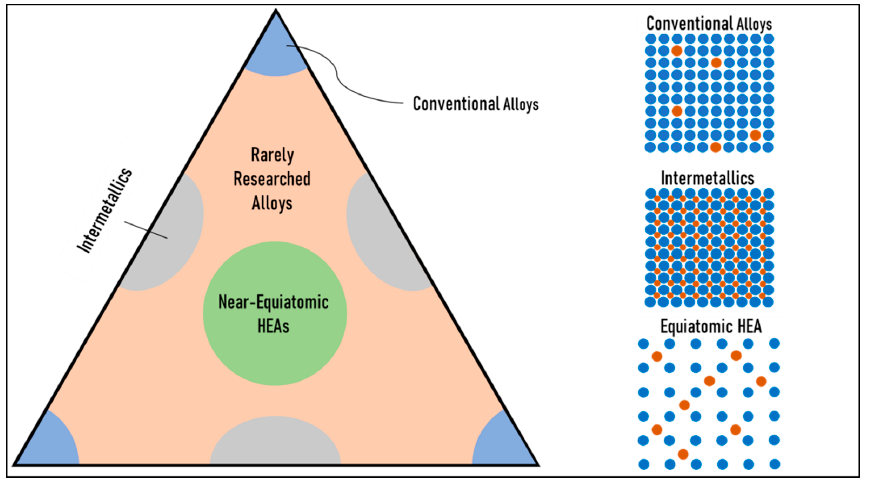
Figure 9. Typical illustration of dilute (compositions at the corners) and complex concentrated (compositions at and near the center) alloys.